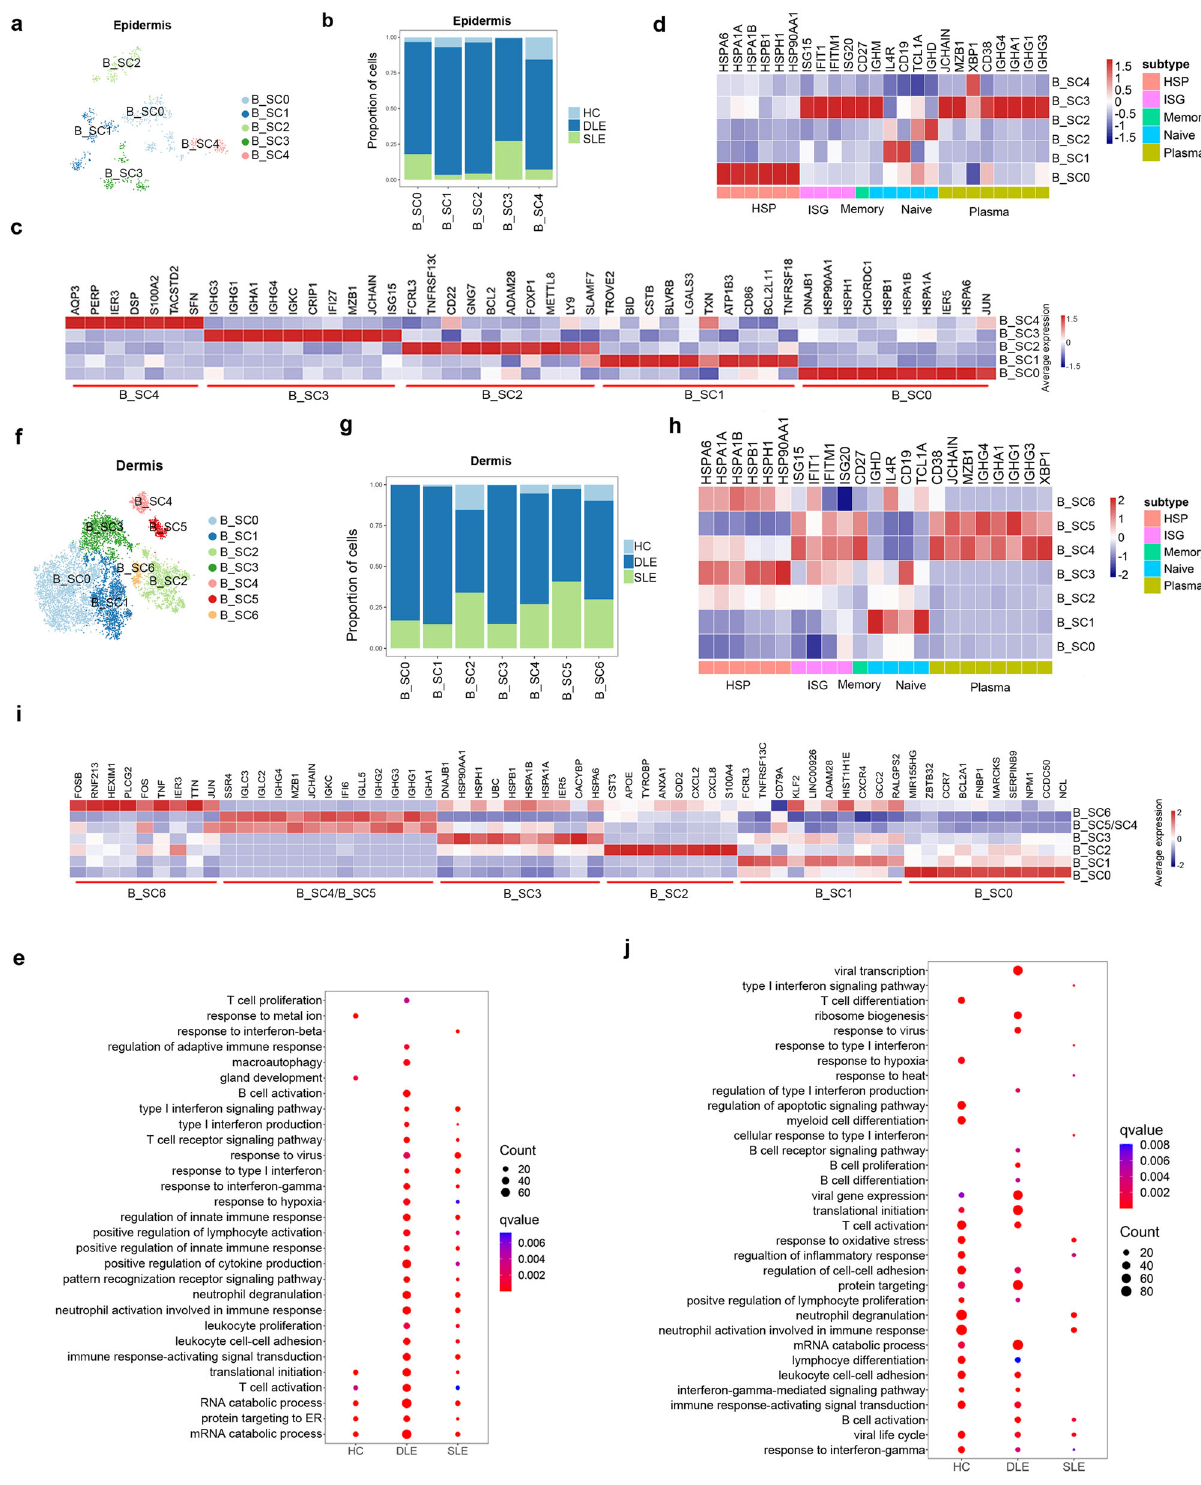
Fig. 6 | Sub-clustering analysis of B cells implicates major B cell subclusters. a , f t-SNEs plot B cell subclusters(SCs)distribution in epidermis( a ) and dermis ( f ). b , g Bar plots show the proportions of cells from HC, DLE and SLE in B cells SCs of epidermis ( b ) and dermis ( g ). c , h Heatmaps show the top 10 differentially expressed genes in 5 epidermal B cell SCs and 7 dermal B cell SCs. d , h Heatmaps show speci fi c classical genes expression in B cell SCs of epidermis ( d ) and dermis